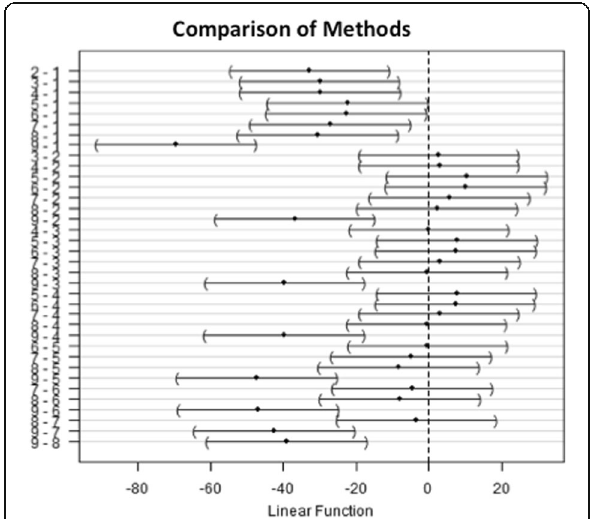
sections using grey-scale analysis, taking a mean of the levels of grey in the images of the aligners cleaned by each method. The cleaner aligners are darker in colour and show grey-scale levels closer to that of the unused aligner, i.e. 61.924, which appears totally dark. Bacterial proliferation on the surface of the aligner, on the other hand, makes them appear lighter in colour, and the multi-layer biofilm causes the mean level of grey to dif- fer considerably from that of the clean TPU of the un- used aligner. By statistically analysing this data, we were able to confirm that there was indeed a statistically sig- nificant relationship between the SEM grey-scale levels and the cleanliness of the aligner sections.